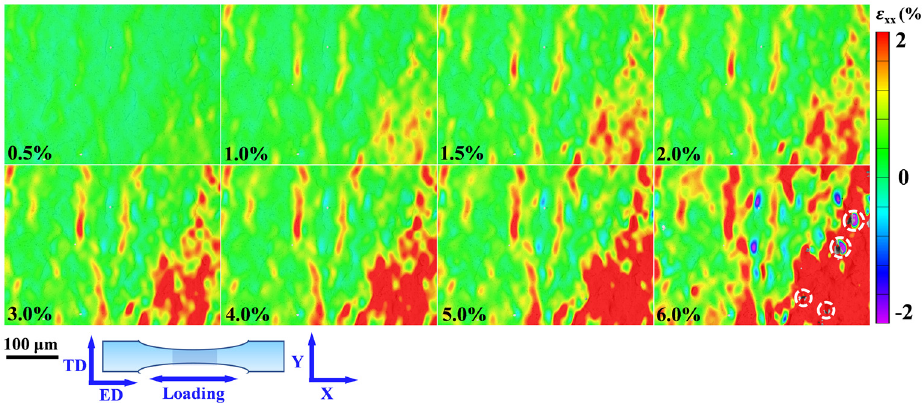
Figure 10. Strain evolution ε xx (parallel to the tensile direction) of hot-extruded bulk Mg. Figure 10. Strain evolution 𝜀 (cid:3051)(cid:3051) (parallel to the tensile direction) of hot-extruded bulk Mg. Figure 10. Strain evolution 𝜀 (cid:3051)(cid:3051) (parallel to the tensile direction) of hot-extruded bulk Mg.